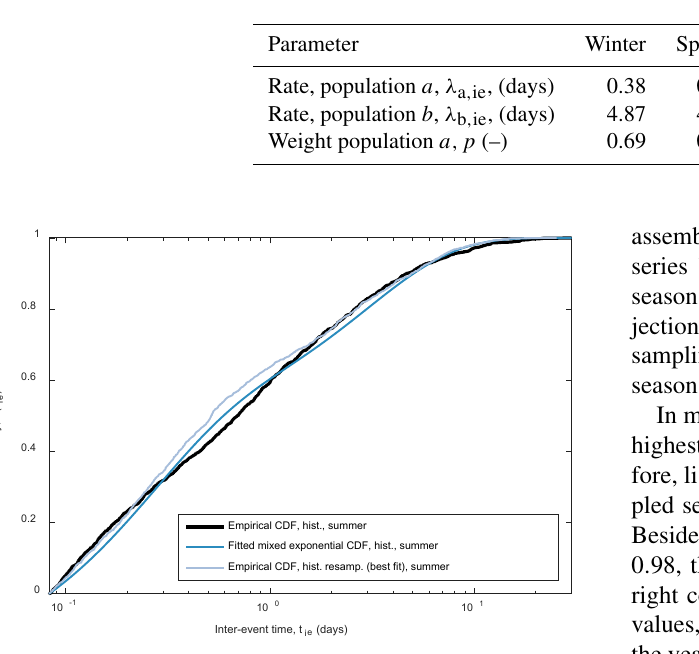
Table 3. The fitted rate and weight parameters for the mixed exponential distribution specified for each season.